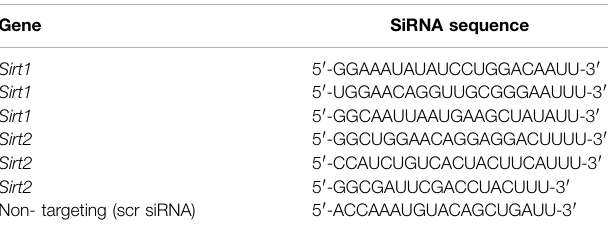
TABLE 2 | Sequences of the custom SiRNA molecules used to Knockdown Sirtuin